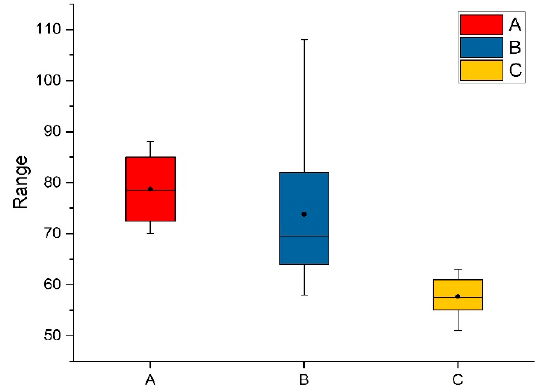
Figure 8. The average access time of image data. The unit of the Y -axis is in milliseconds. ( A – C ) represent the average access time for the client to obtain image data under di ff erent browsing situations. During testing, extreme cases of brute force browsing were ruled